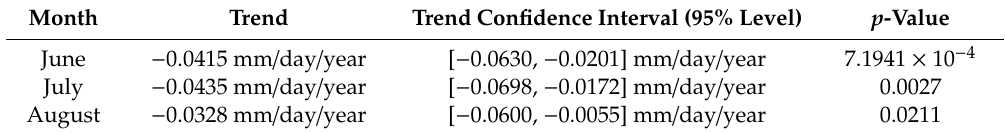
Table 2. Statistics of Vegetation Condition Index (VCI), Temperature Condition Index (TCI), and VHI anomaly trends of HOA cropland from the years 2001 to 2017.